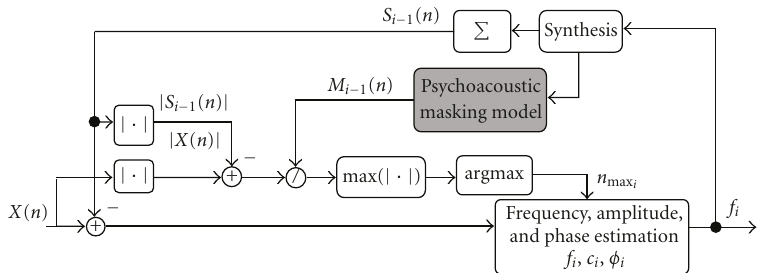
Figure 5: Frequency domain implementation of the analysis/synthesis loop including a psychoacoustic masking model for extraction and parameter estimation of individual